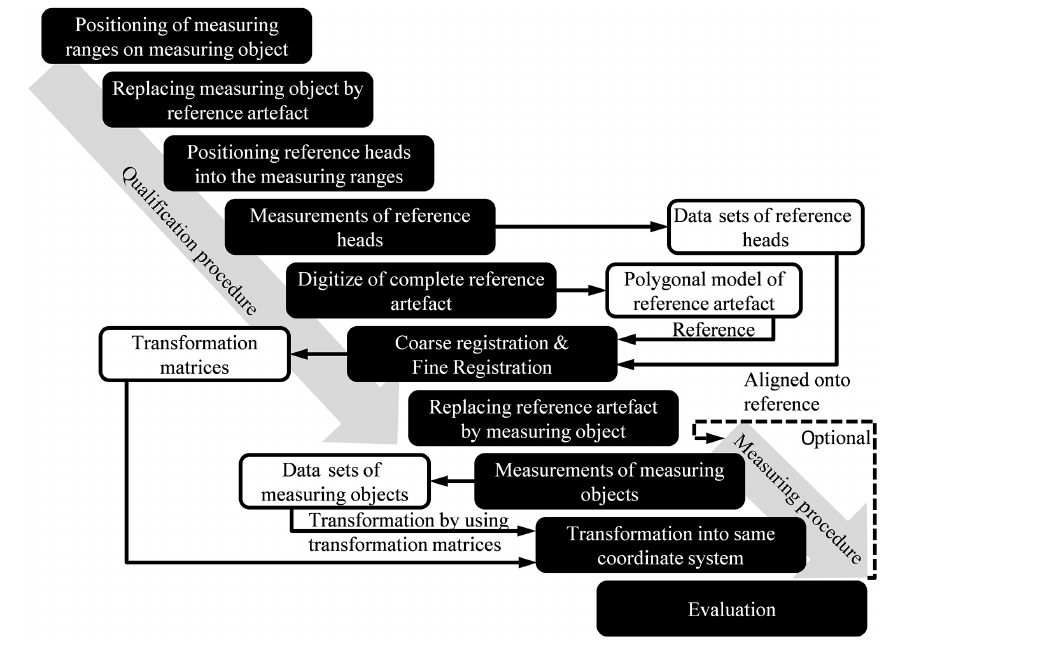
Figure 7. Complete steps for the qualification and measuring procedure.